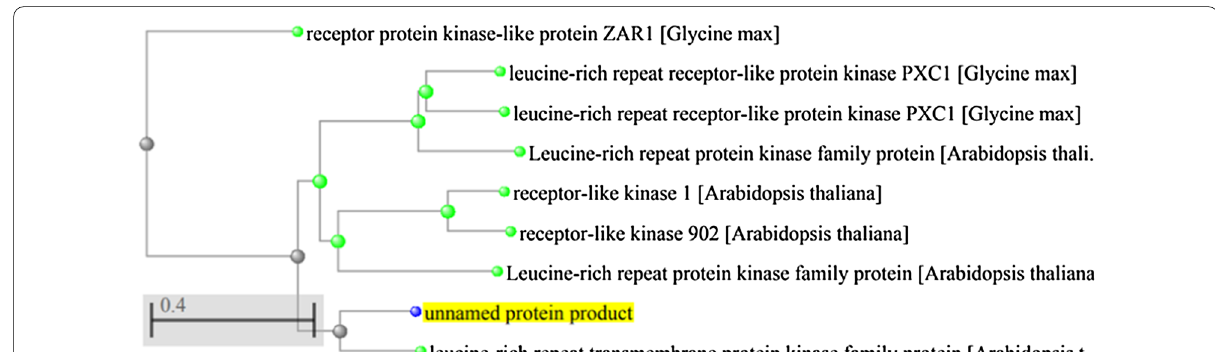
Fig. 2 The results of GSH118 protein sequence searched in the reference protein database with over 95% overlapping, the phylogenic tree was constructed using a method based on fast minimum evolution with a maximum sequence difference of 0.85 using the Grishin distance model